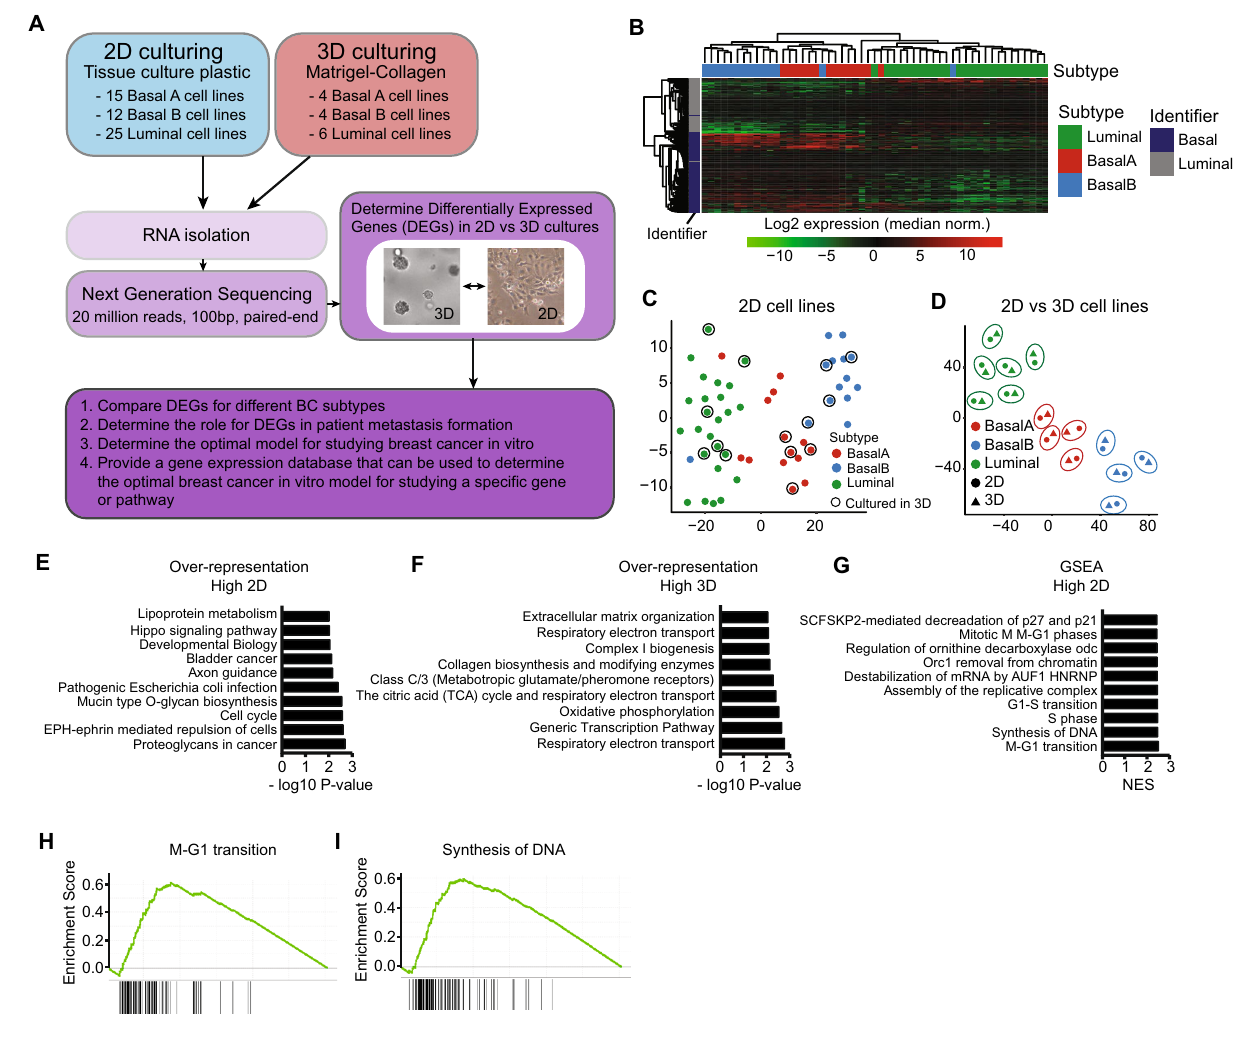
Figure 1. RNA sequencing of breast cancer cell lines cultured in 2D and 3D environments. ( A ) Experimental overview. RNA was isolated from cell lines cultured in 2D and 3D conditions (see Methods section for more details), upon which next generation sequencing was performed. Cell line specific Differentially Expressed Genes (DEGs) were selected based on log2 fold change > 1 or < − 1. Subtype specific DEGs were determined using a paired cell line analysis and selected if the parametric p -value < 0.01. See “Methods” section for further details. ( B ) Hierarchical clustering (complete linkage, correlation) of log2 expression levels of previously defined basal and luminal identifiers 29 in 2D cultured cell lines. For every gene, expression levels were normalized to the median cell line expression. ( C ) T-sne of all cell lines cultured in 2D based on log2 normalized reads from all detected genes. Encircled cell lines were also cultured in 3D in this study. ( D ) T-sne of cell lines cultured in both 2D and 3D conditions based on log2 normalized reads from all detected genes. 2D and 3D conditions of the same cell line are encircled. ( E ) Top 10 over-represented pathways in DEGs higher expressed in 2D cultures. DEGs were determined using paired analysis for all cell lines, p < 0.01. ( F ) Top 10 over-represented pathways in DEGs higher expressed in 3D cultures. DEGs were determined using paired analysis for all cell lines, p <